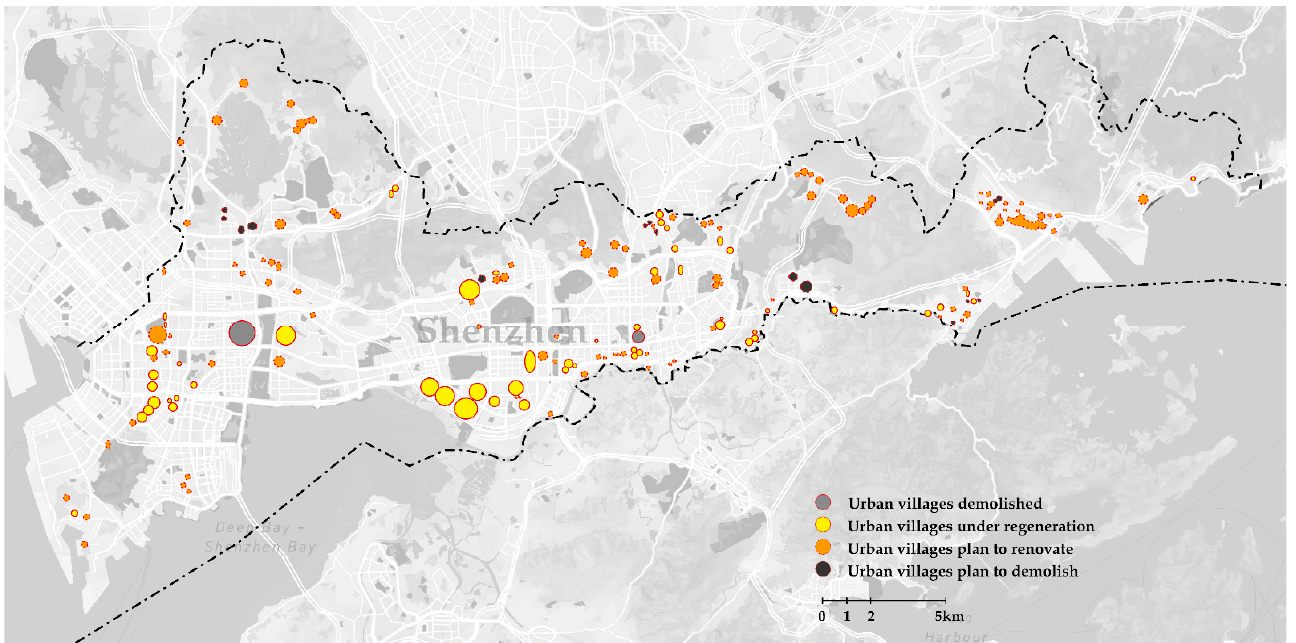
Figure 3. Development program of urban villages in the core area of Shenzhen.